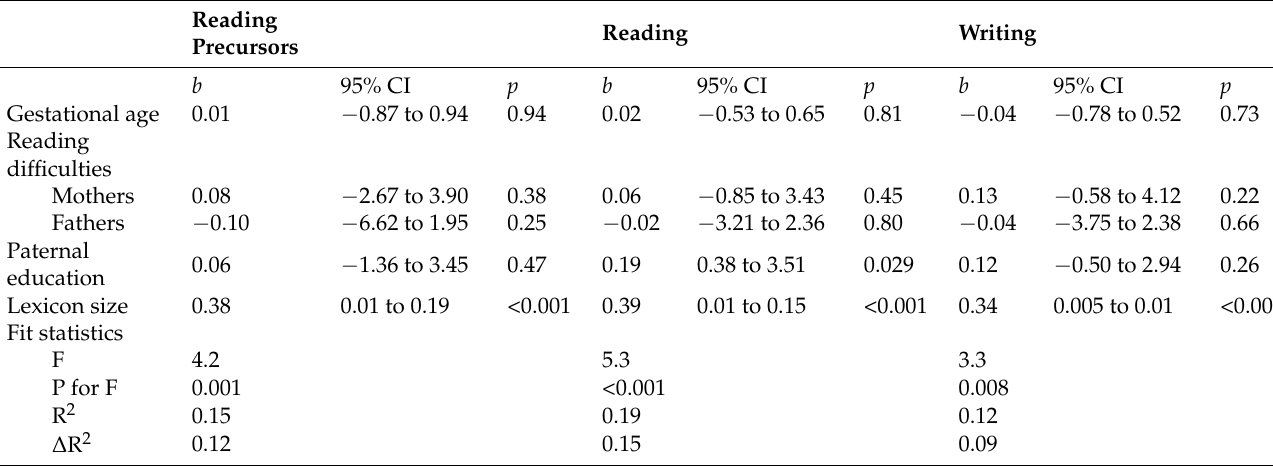
Table A1. Results of multiple variable linear regression analysis with reading precursors, reading, and writing skills at 7 years of age as dependent variables, and with lexicon size at 2 years of age and background factors as independent variables. Results of full-term controls are presented.